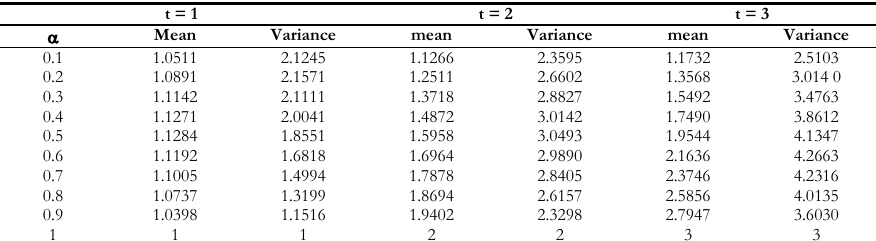
Table showing values of mean and variance of the Mittag-Leffler count model probabilities for different values of the parameter  at t =